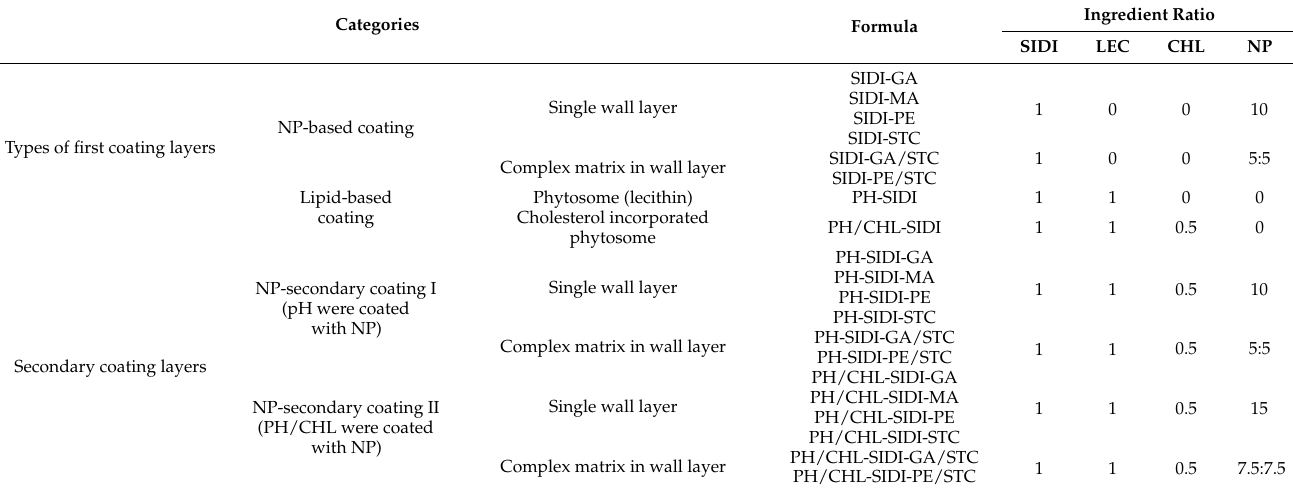
Table 1. Encapsulation design: Ratio between ingredients of each